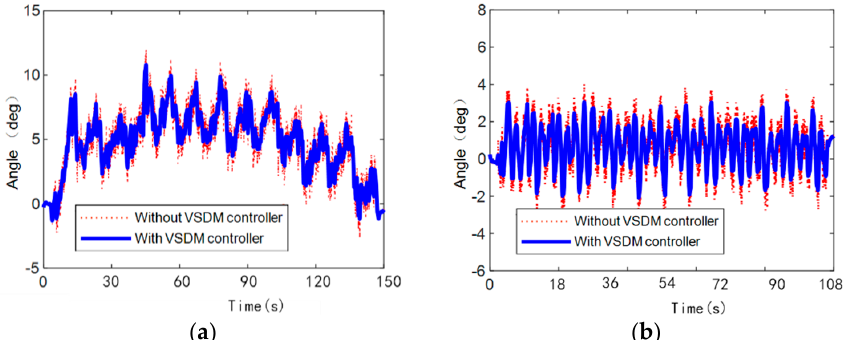
Figure 22. The curves of pitch angle and roll angle observed in climbing the ladder: ( a ) Pitch angle in stair climbing, and ( b ) roll angle in stair climbing.